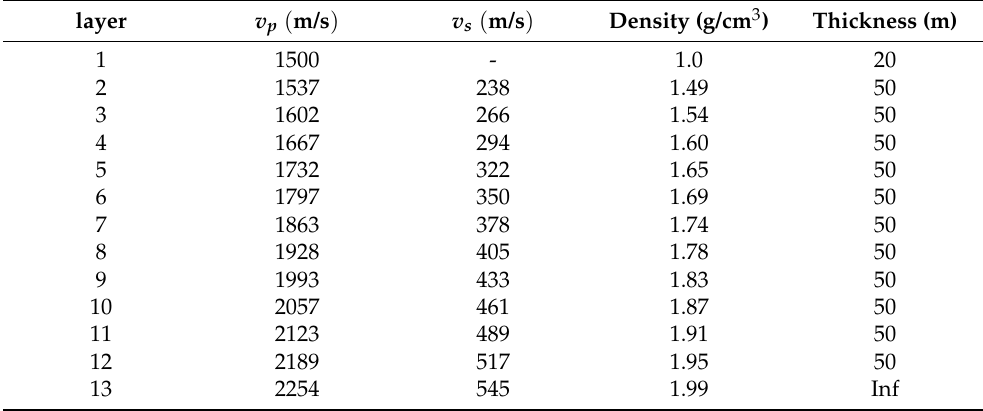
Table 3. Parameters of the initial